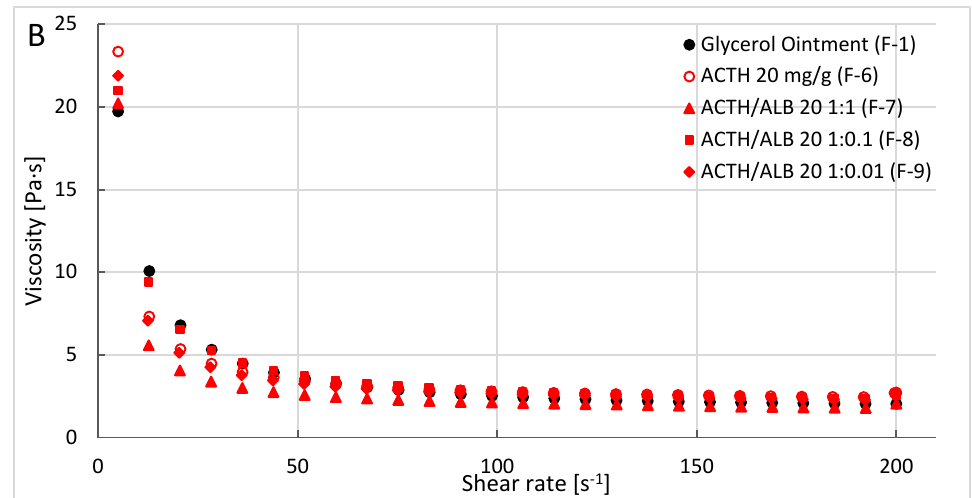
Figure 4. Viscosity curves for formulations containing ACTH at concentration 15 mg/g (F-2) and ACTH at concentration 15 mg/g and albumin (F-3–F-5) ( A ) and for formulations containing ACTH at concentration 20 mg/g (F-6) and for formulations containing ACTH at concentration 20 mg/g and albumin (F-7–F-9) ( B ) with regard to Glycerol hydrogel-F-1, n = 5.